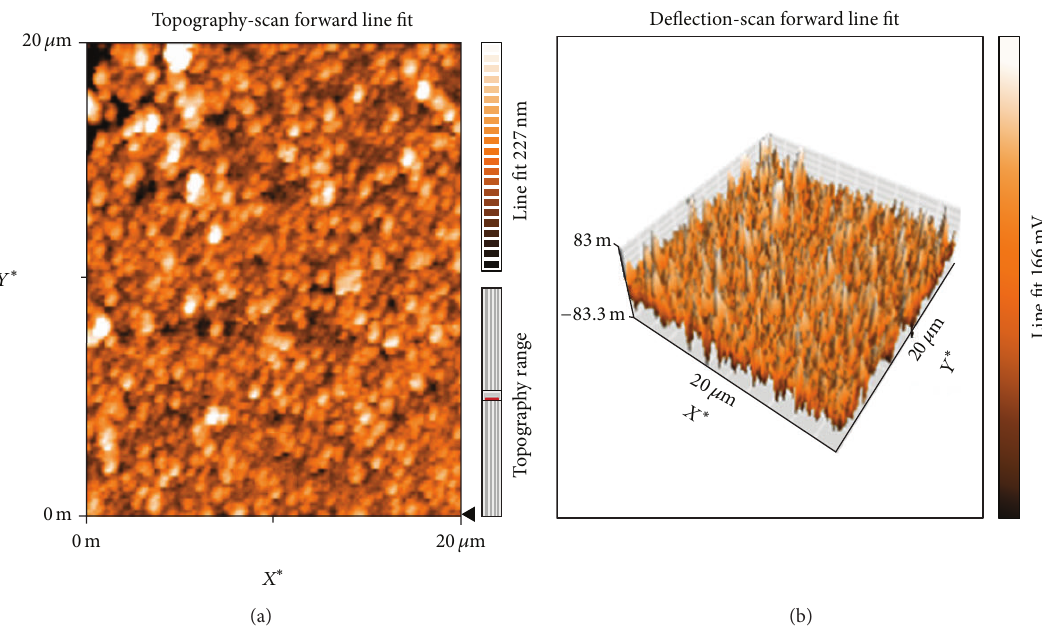
Figure 4: Atomic force microscopic images of the synthesized AgNPs: (a) aerial view showing topographical characteristics; (b) 3D